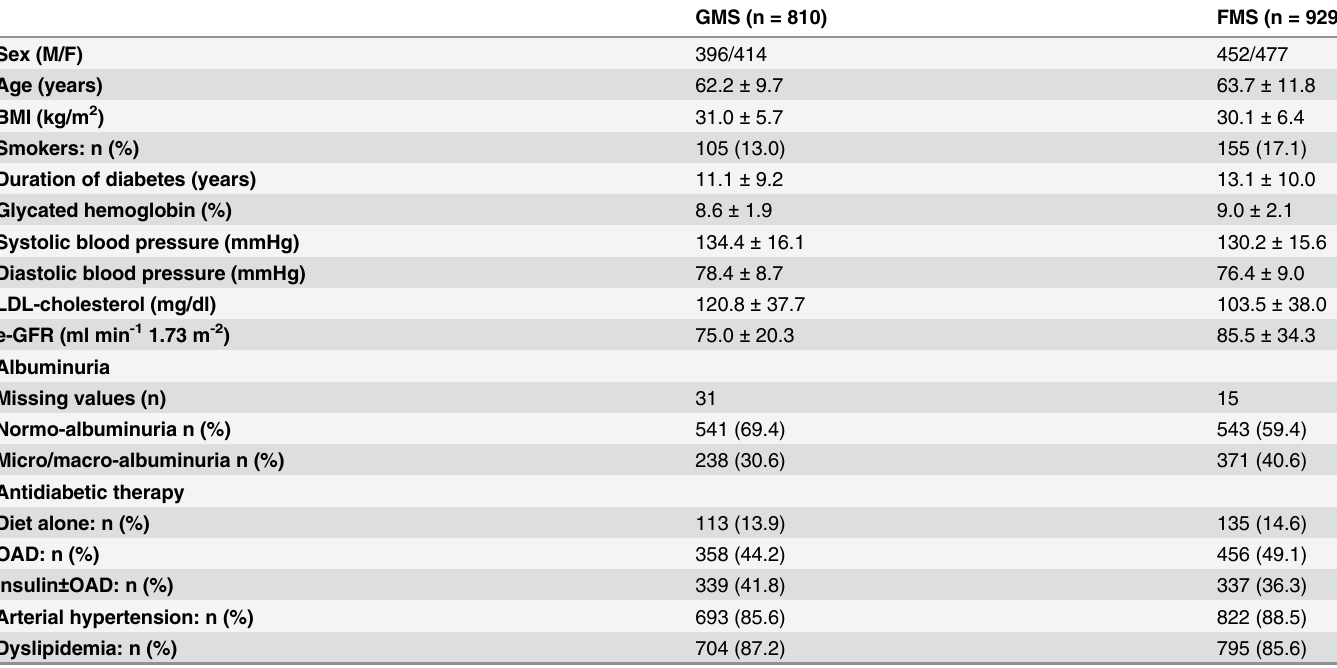
GMS (n = 810) FMS (n = 929)